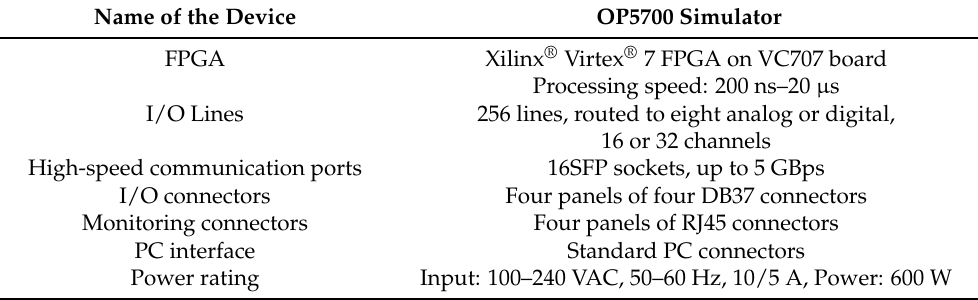
Figure 8. HIL experimental setup for the LLC-RC. Table 4. Hardware-in-loop (HIL) system specifications.